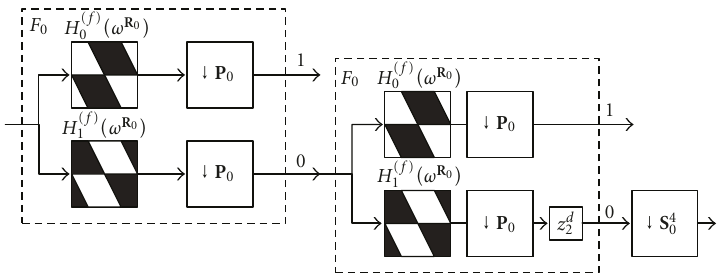
Figure 5: Subband 0 of the 16-band DFB. The figure shows the path (bold line) from level two to level four with corresponding transfer function H 2 − 4 0 ( z ).